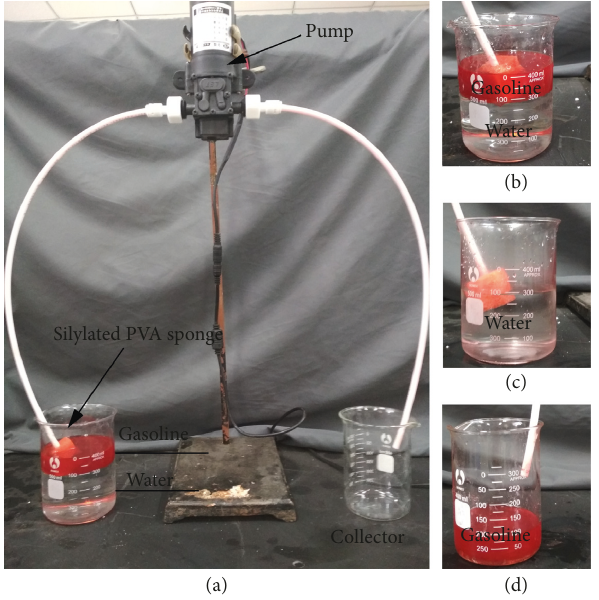
Figure 2: Photographs of (a) the continuous oil-water separation device, (b) oil-water mixture image, (c) water left in the beaker after continuous adsorption, and (d) oil collected during continuous adsorption.